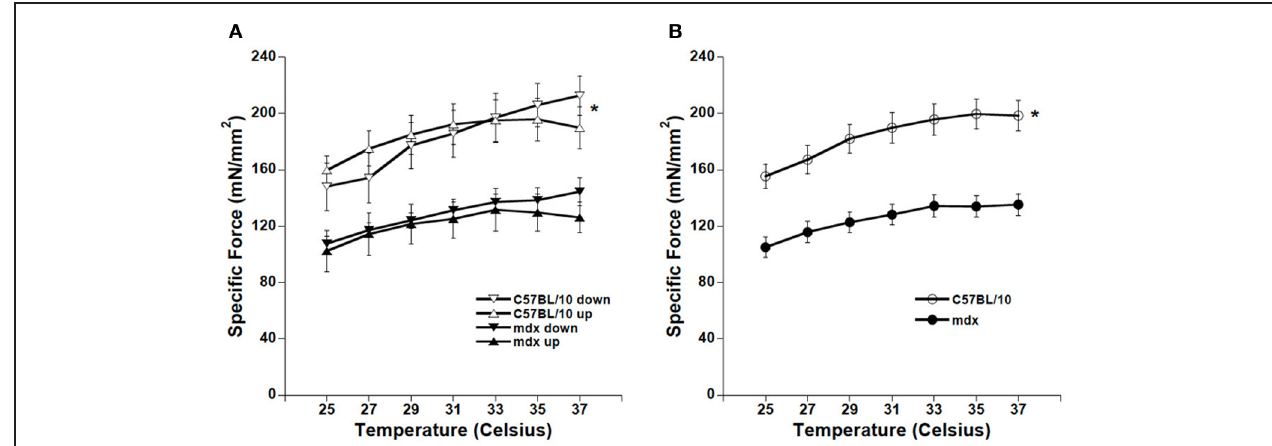
differences in force when comparing within-strain warming vs. cooling groups. (B) Pooled data shows that C57BL/10 diaphragm strips showed higher average force per CSA vs. mdx ( ∗ p < 0 . 01) at all temperatures, and a significant relationship between temperature and force ( p < 0 . 01).